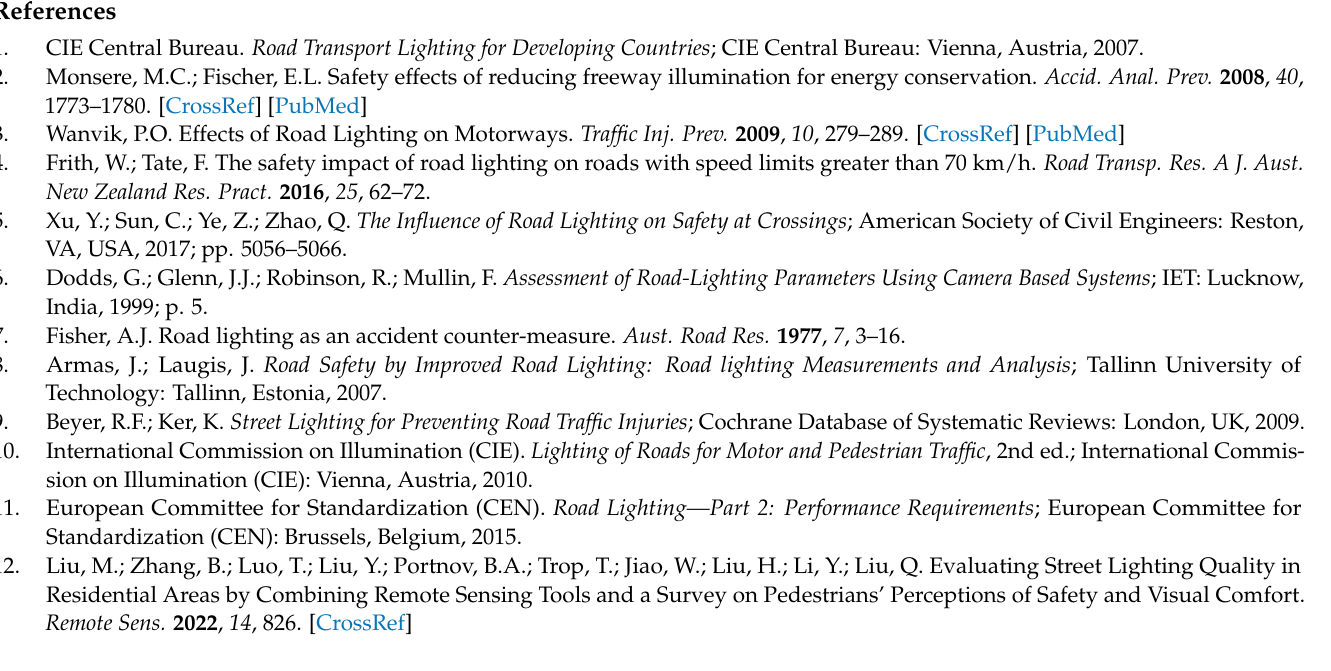
Table S1: Road lighting quality evaluation metrics of the extracted